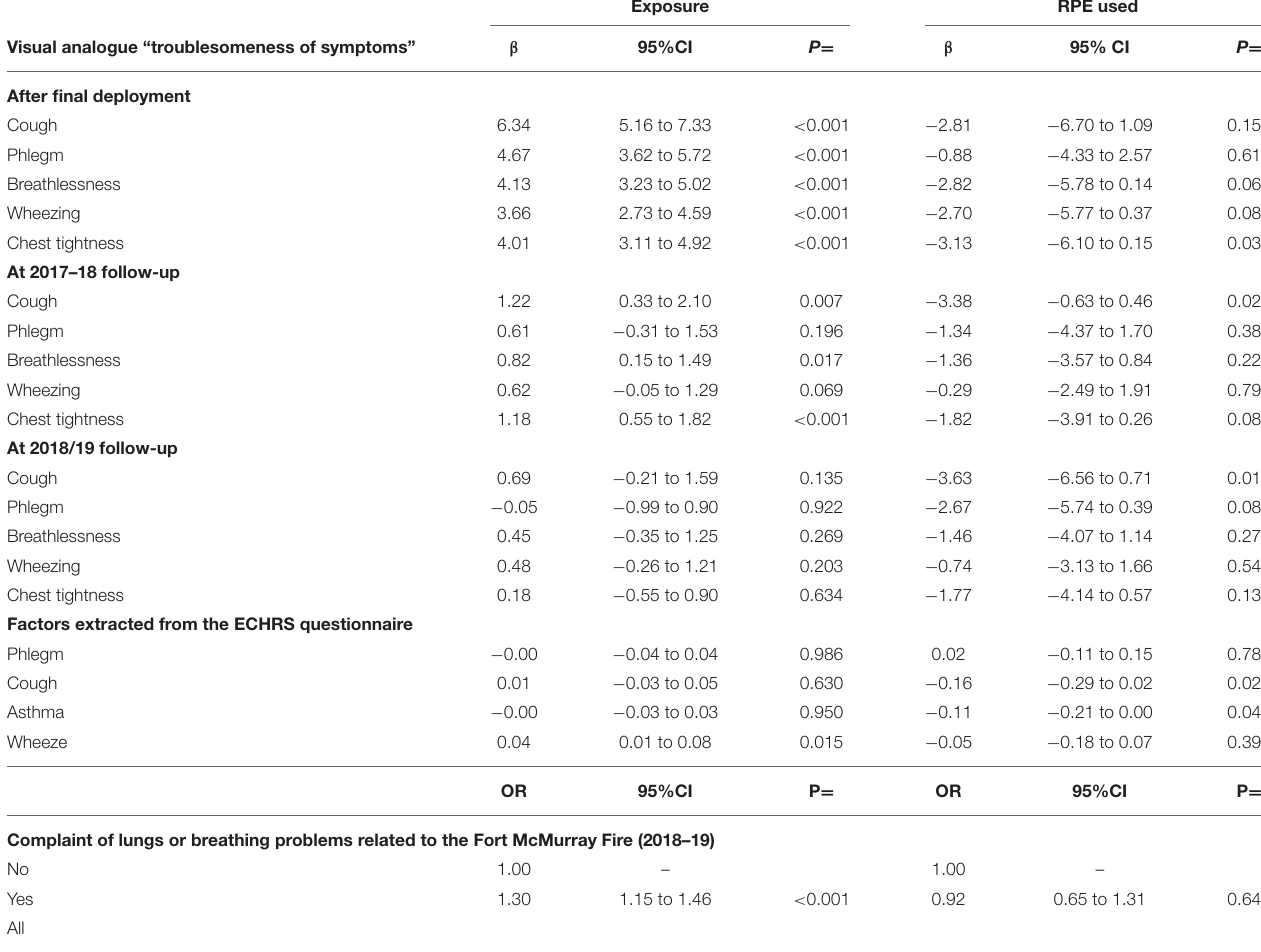
TABLE 3 | Relation of estimated exposure and use of respiratory protective equipment (RPE) to respiratory symptoms and complaints, adjusted * . Exposure RPE used Visual analogue “troublesomeness of symptoms” β